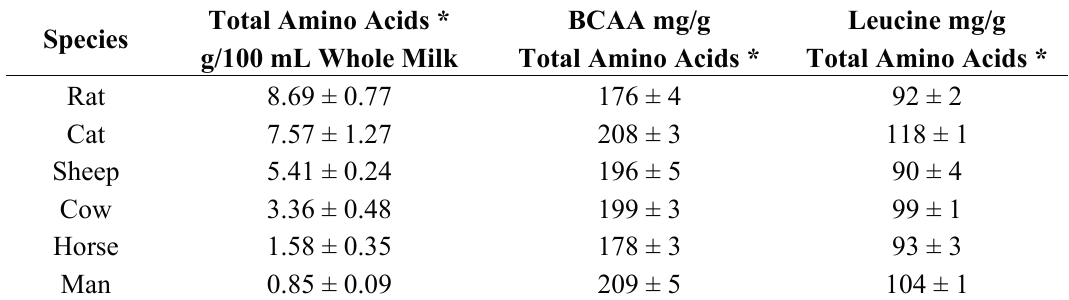
Table 1. Comparison of milk amino acid composition of selected mammalian